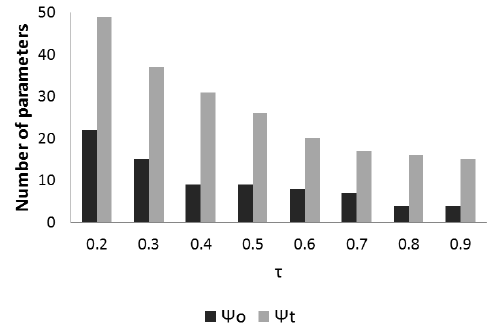
Figure 2. Numbers of relevant parameters identified by the original (dark gray) and extended (light gray) Morris methods as functions of the threshold values τ o and τ t , respectively, for the example of AGB . A parameter was marked as relevant if at any study site µ ∗ was higher than the respective threshold value.